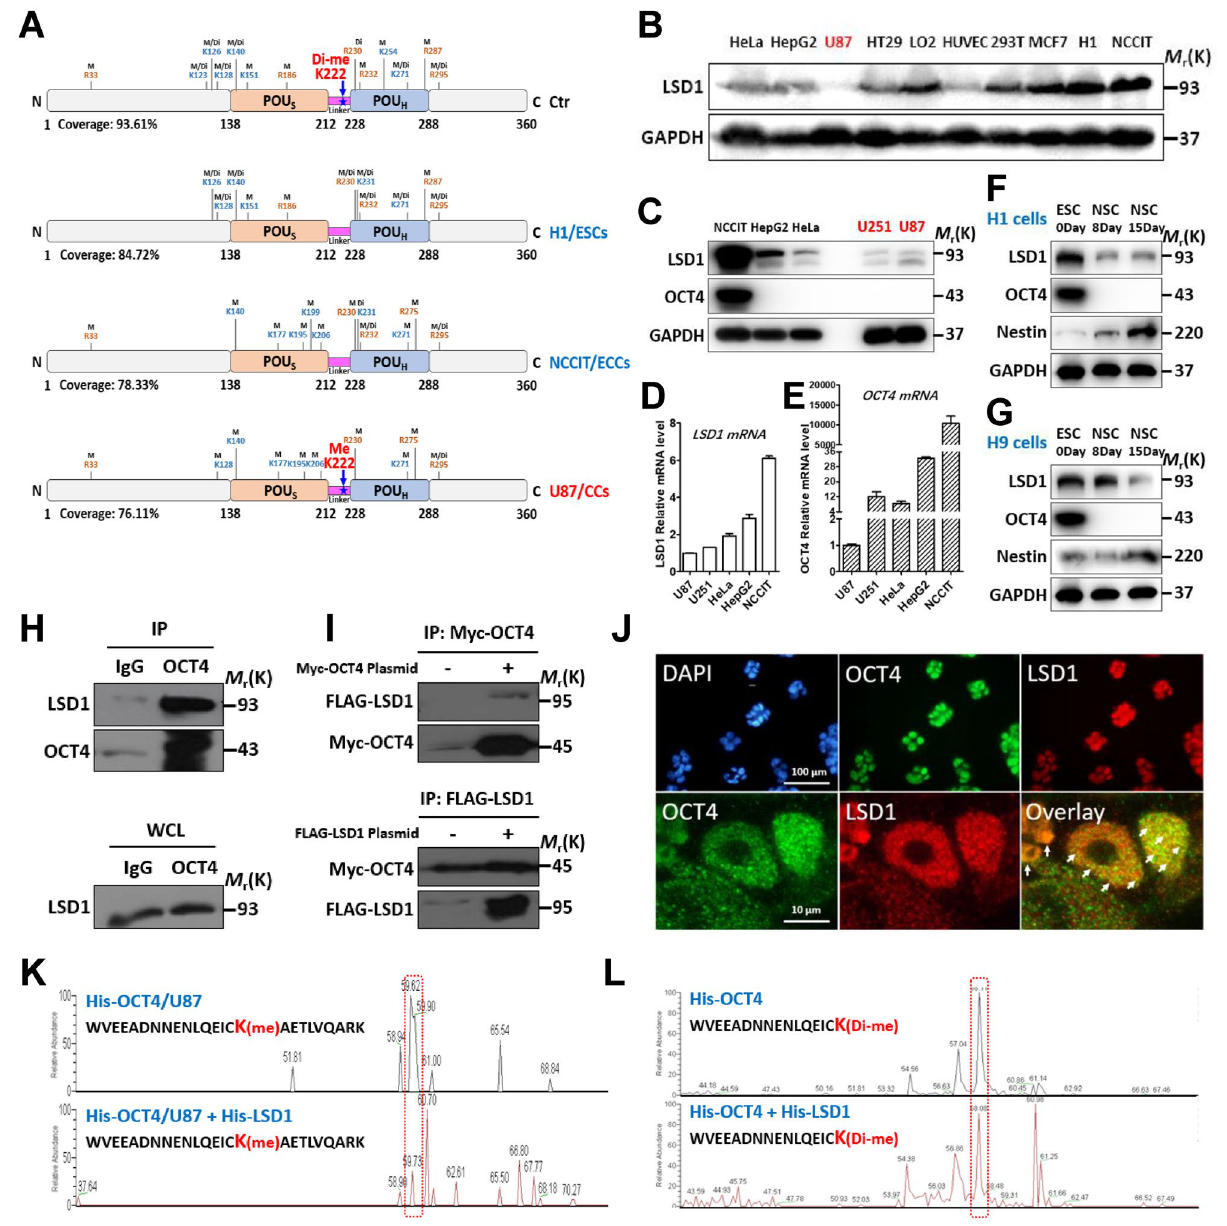
Figure 2. LSD1 is a bona fide demethylase for OCT4-K222. ( A ) Comparison of methylated lysine and arginine residues in non-treated recombinant OCT4 proteins with those in recombinant OCT4 proteins incubated with the lysates from different cell types. M, mono-methylation; Di, di-methylation; K, lysine; R, arginine. ( B ) Immunoblotting analysis of LSD1 protein levels in multiple human cell lines that include non-transformed differentiated cells, cancer cells, an ESC and an ECC. ( C – E ) Whole cell lysates of multiple cell lines were immunoblotted with anti-LSD1 and anti-OCT4 ( C ), and their LSD1 mRNA levels ( D ) and OCT4 mRNA levels ( E ) were determined by qRT-PCR. ( F , G ) H1 ( F ) and H9 ( G ) hESCs were induced to NSCs for 8 and 15 days, and the whole cell lysates were immunoblotted with the indicated antibodies. ( H , I ) Endogenous OCT4 proteins in NCCIT cells ( H ) and Myc-OCT4 proteins ectopically-expressed in 293 T cells ( I ) were immunoprecipitated with specific antibodies and immunoblotted with the indicated antibodies. ( J ) Co-localization of endogenous OCT4 and LSD1 proteins in NCCIT cells. White arrows marked the co-localization spots in different cells forming a single colony. ( K , L ) Recombinant His-OCT4 proteins were incubated with recombinant His-LSD1 proteins in the presence ( K ) or absence ( L ) of U87 whole cell lysates in PMA buffer for 1 h and subjected for MS analysis. The peak profiles of the peptides spanning the di-methylated and mono-methylated OCT4-K222 were presented. Cropped immunoblot images were presented for ( B ), ( C ), ( F ), ( G ), ( H ) and ( I